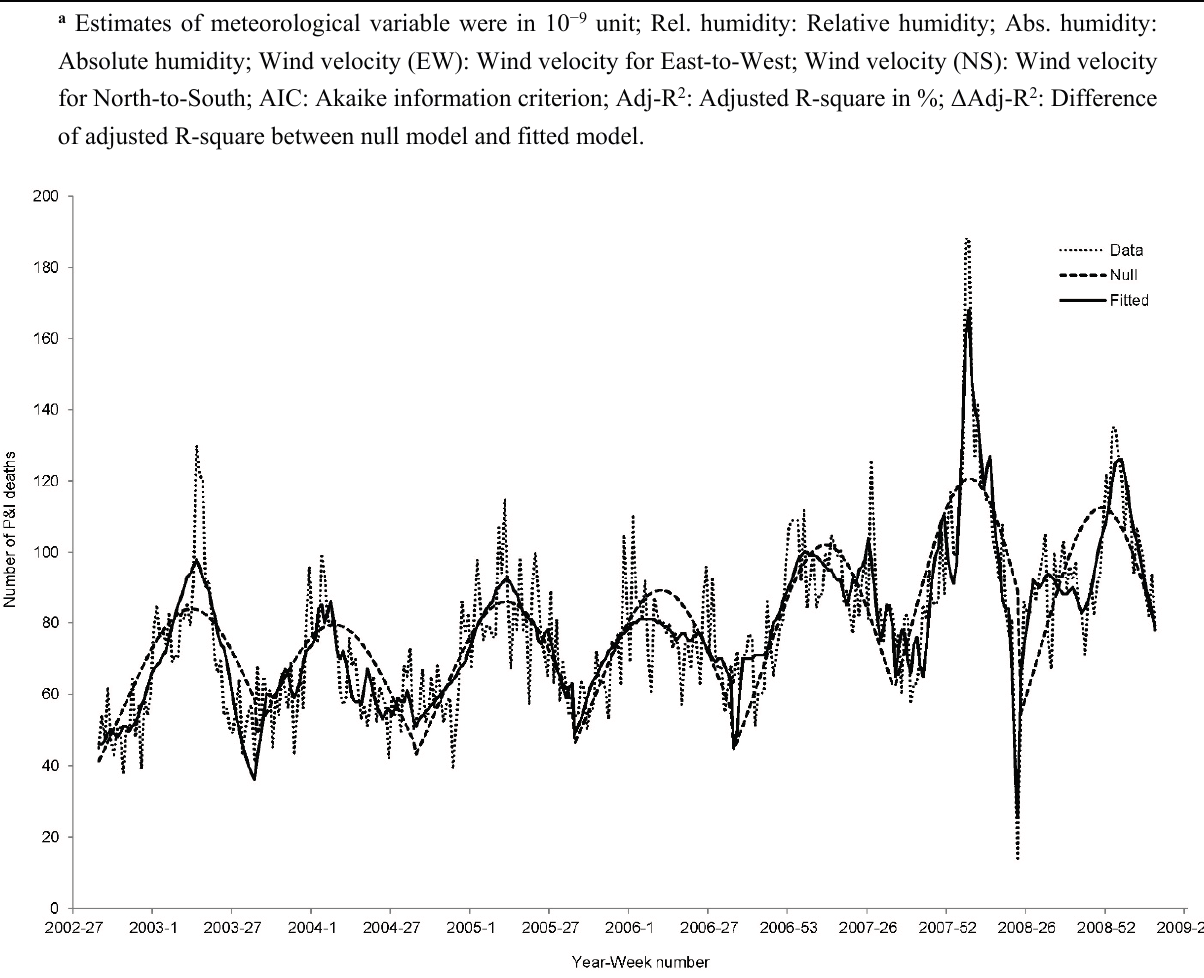
Figure 3. Fitted curves from the null model and the best fitted